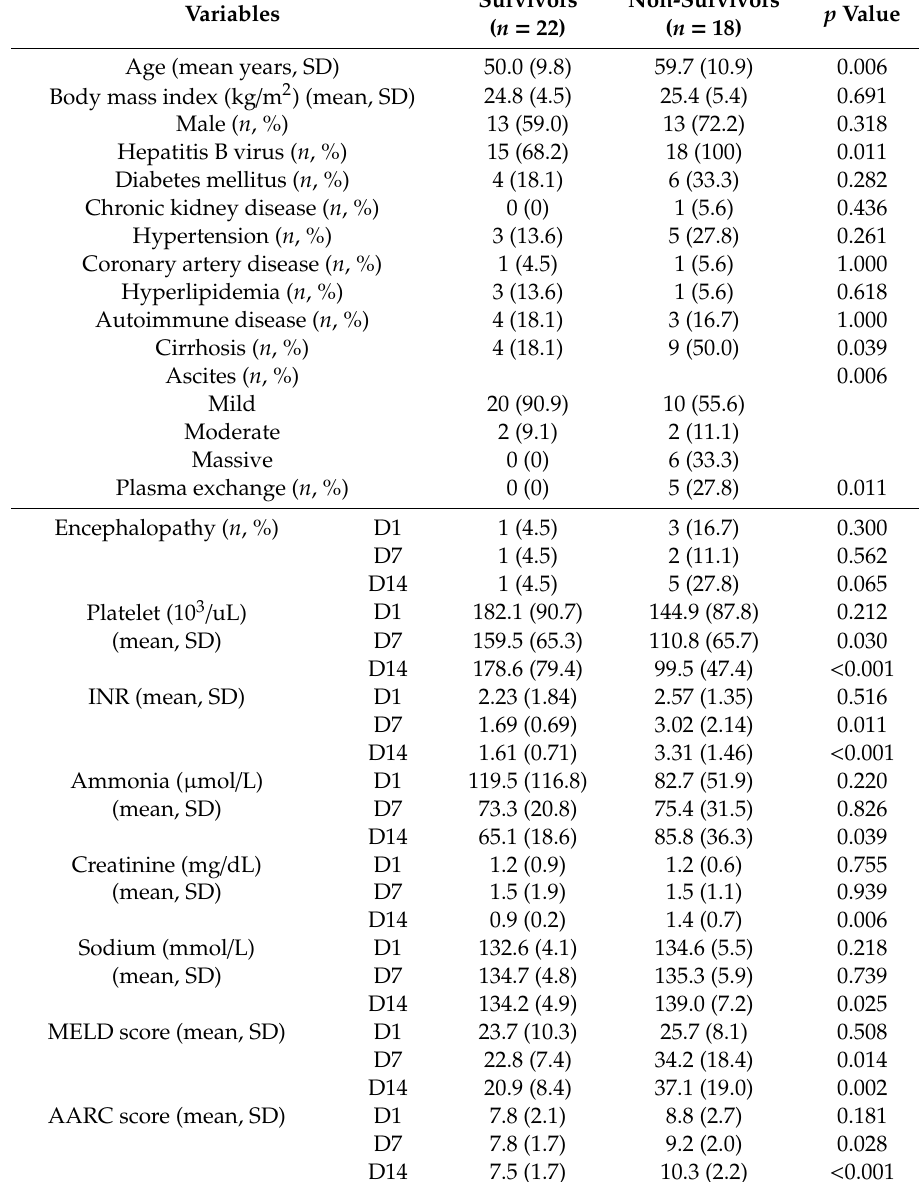
Table 2. Characteristics of transplant-free patients with acute-on-chronic liver failure (ACLF) (3-month survivors and